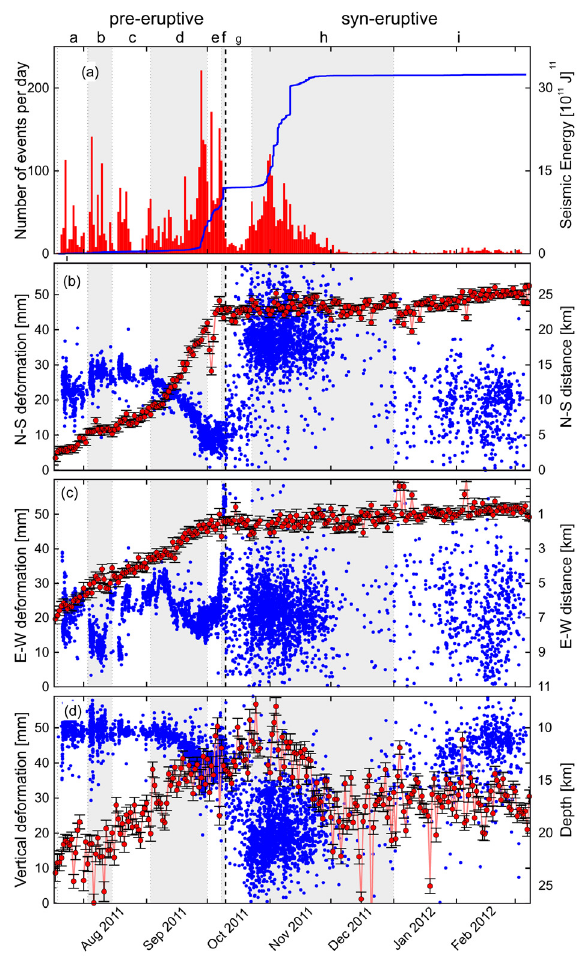
Figure 3. (a) Temporal evolution of the daily number of earth- quakes with magnitude >1.5 (red histograms) and the accumulated seismic energy curve (blue line). (b-d) Blue dots: temporal evolu- tion of the (b) North-South and (c) East-West distances (km) to the vent and of the (d) depth (km) of the earthquakes after relocation of Domínguez Cerdeña et al. [2014]; red dots (with the axis error) N-S, E-W and vertical components of ground deformation recorded at GPS station FRON (the only station that was active since the very onset of the unrest) during the pre-eruptive and syn-eruptive phases of the 2011-2012 El Hierro eruption. Black dashed line indicates the onset of the eruption. Shaded and white alternating areas indicate the nine phases in which authors divided the pre-eruptive unrest and eruptive